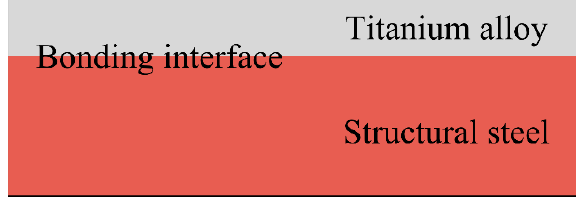
Figure 1. Illustration of TC bimetallic steel.